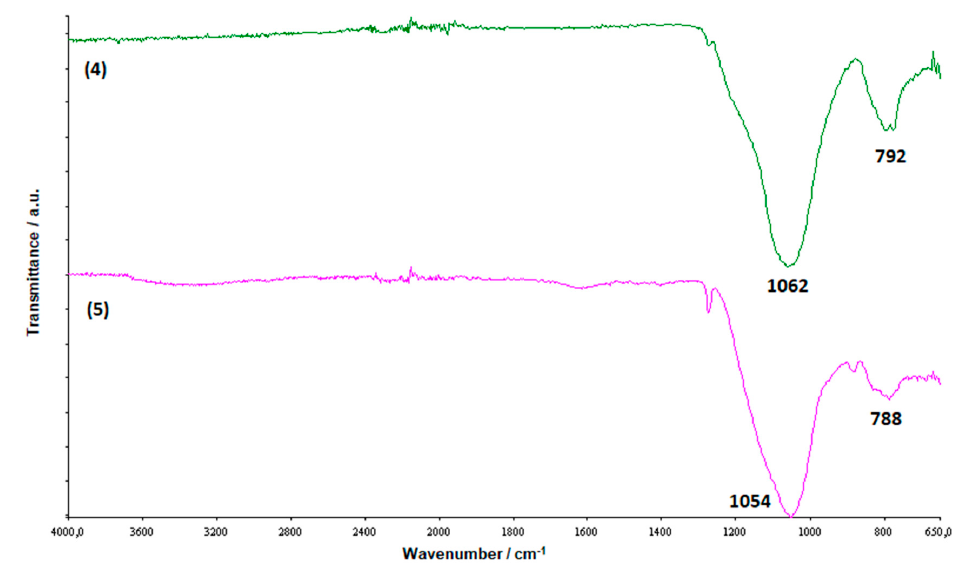
Figure 10. FTIR spectra of the residues at 700 °C, in static air atmosphere, for the samples 4 and 5 .